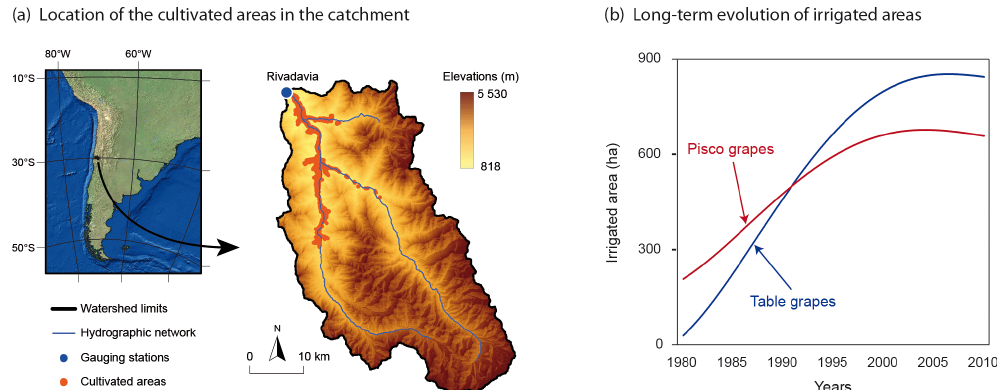
Figure 1. The Claro River catchment in Chile: (a) location of the cultivated areas in the valley floors, and (b) long term evolution of irrigated areas as estimated from national cadastral surveys conducted from 1980 to 2010 for two main varieties cultivated in the